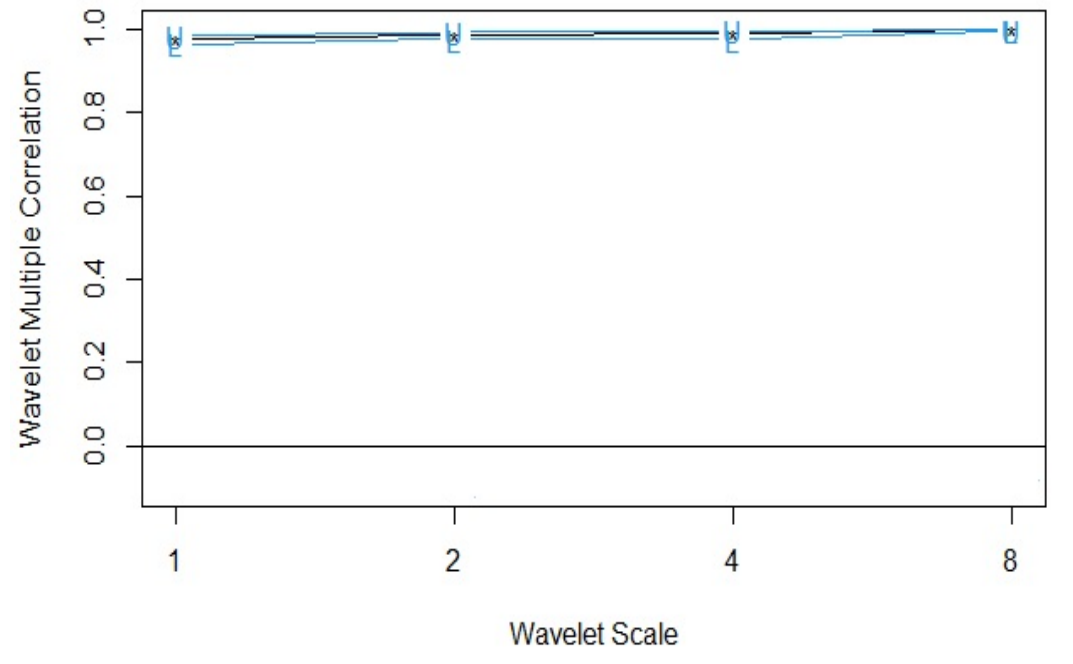
Figure 8. Wavelet multiple correlations between GSE and banking sector financial soundness. U— upper limits, L—lower (at 95% confidence interval), *—plots of actual WMC values. Table 2. Wavelet multiple correlations between GSE and banking sector financial soundness.